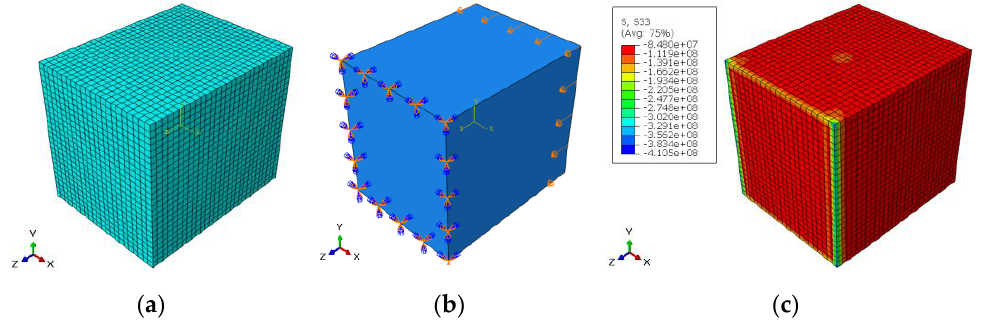
Figure 9. ( a ) FE model, ( b ) boundary conditions and ( c ) stress distribution for tangential direction.